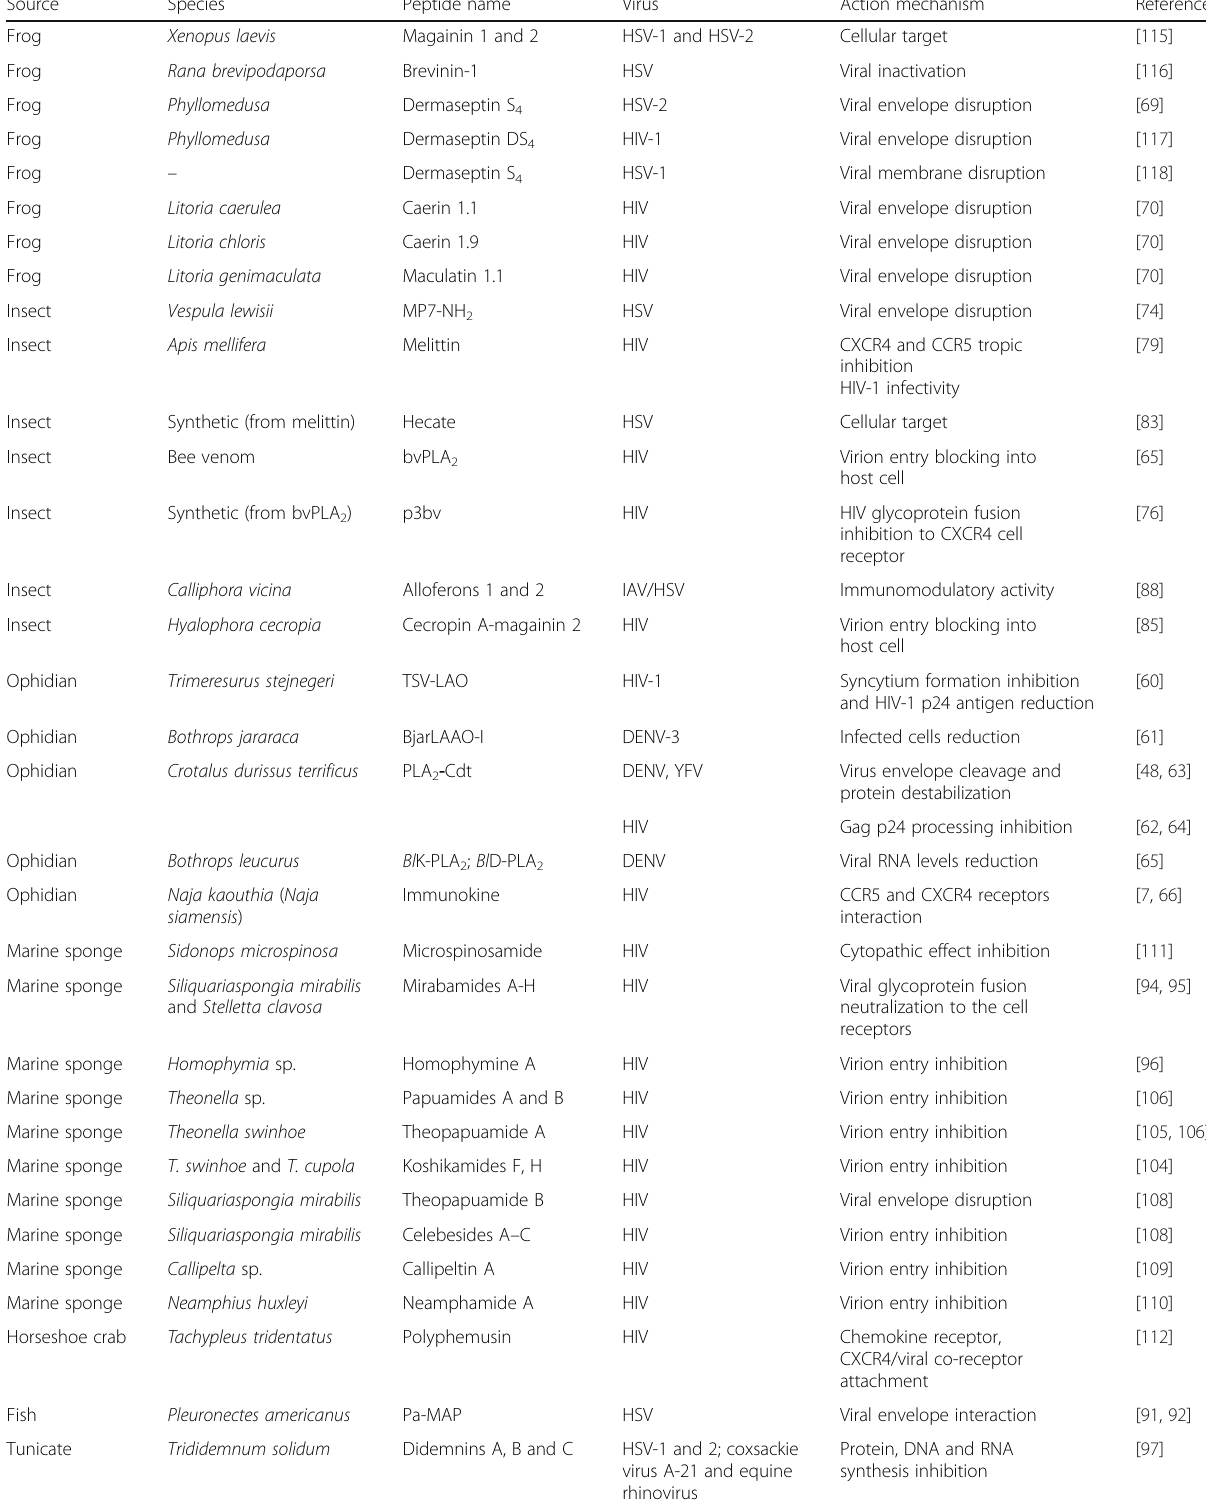
Table 2 Examples of animal peptides presenting antiviral